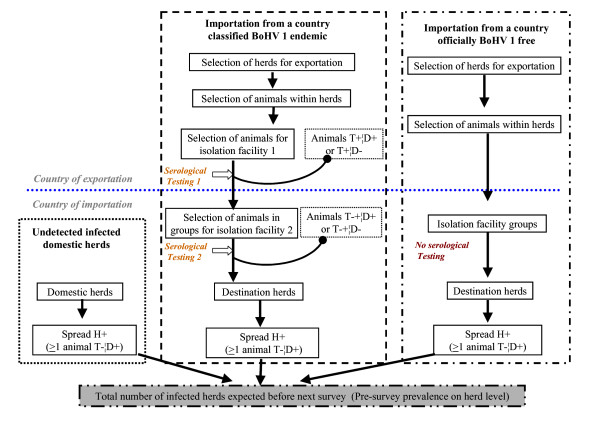
Basic model structure and cattle import pathways. Basic structure of the stochastic simulation model to estimate the pre-survey probability of freedom from infection as applied to BoHV-1. Three main pathways of infectious agent introduction into the susceptible domestic population were considered. + = infected, - = uninfected, D = infection status of animal, T = diagnostic test status of animal, H = herd status